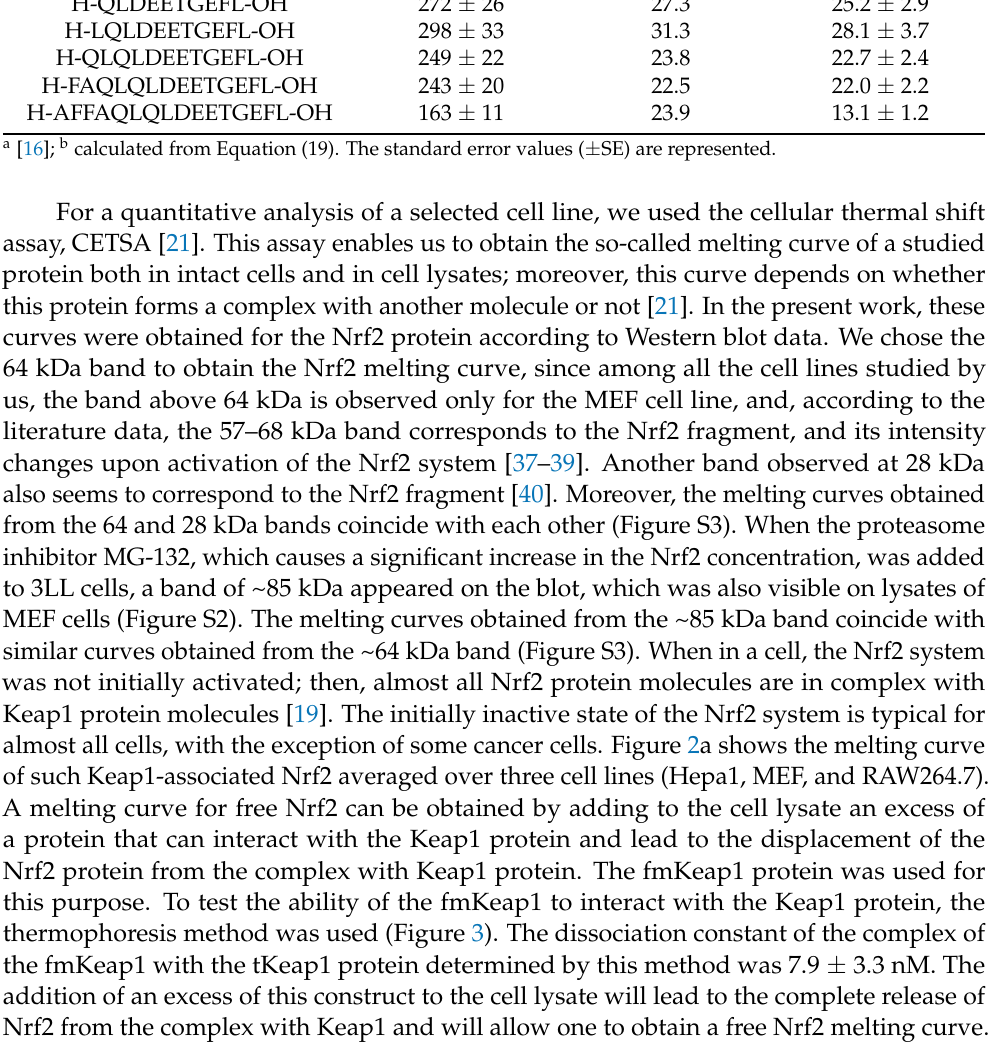
Table 1. The inhibition of the Keap1:Nrf2 interaction by Nrf2 peptides. Peptide Sequence IC 50 , nM a H-LDEETGEFL-OH 3480 ± 920